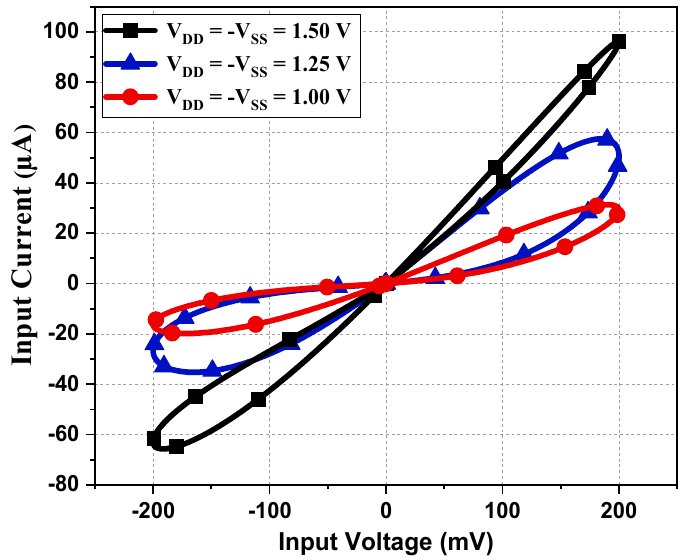
Figure 9. PHL at different process corners.